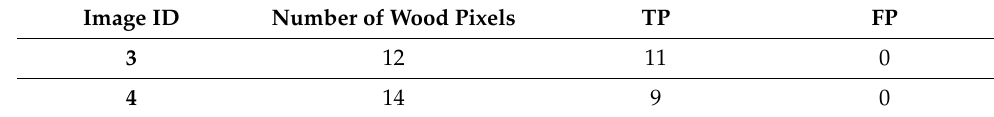
Table 5. Table with the true and false positive numbers for S2 images 2 and 3.